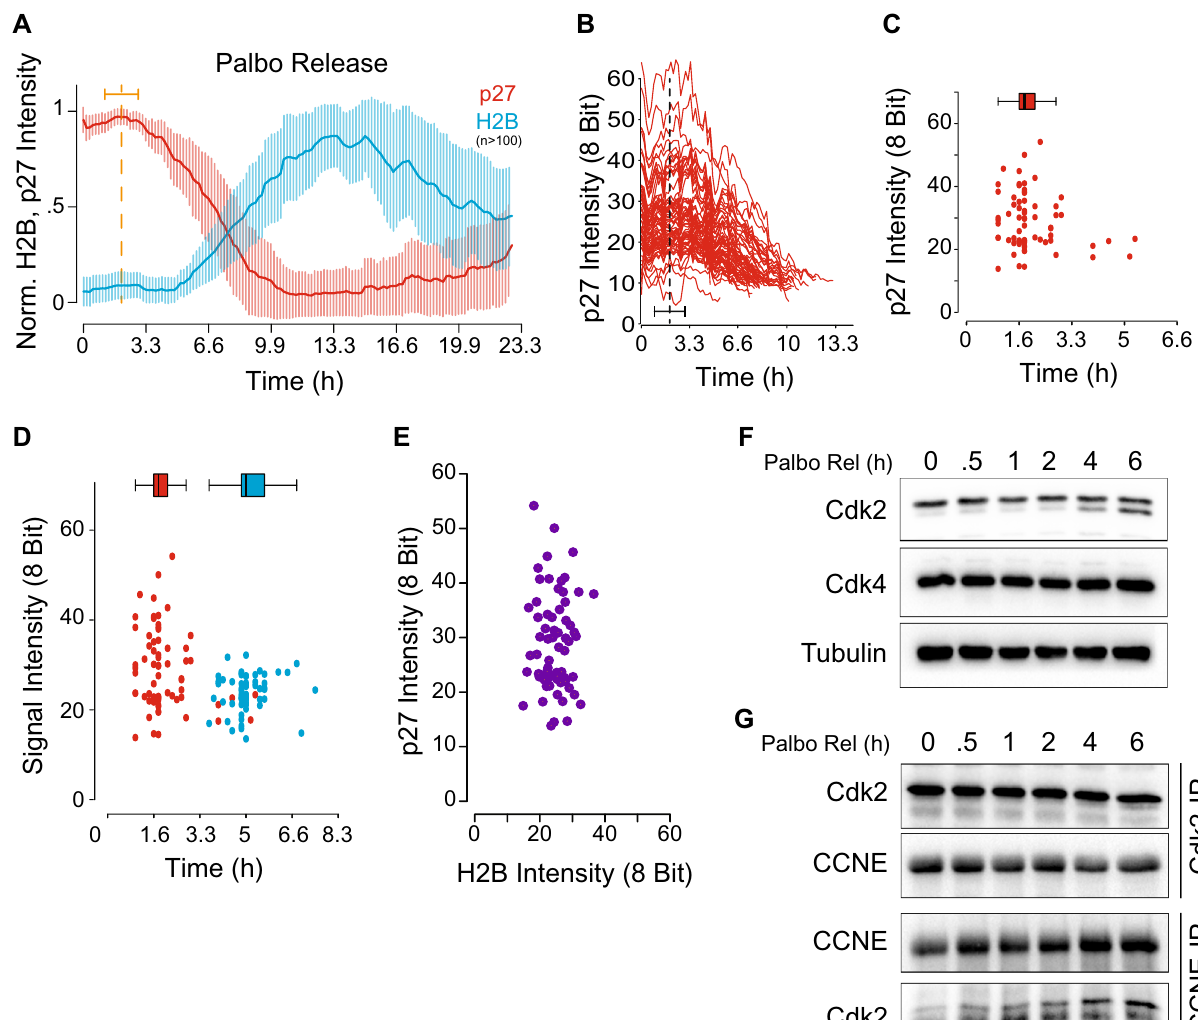
Figure 1. p27-mCherry, a single cell reporter for cell cycle entry. ( A ) Average over single cell p27-mCherry and H2B-eGFP signals during a Palbociclib release. Bold red and blue lines indicate an average over 10 for endogenous p27 or H2B, respectively. Thin vertical red and blue lines indicate the standard deviation at this time point over the past and future 5 time points. ( B , C ) Heterogeneity of single cell p27-mCherry signals. Data derived from ( A ). Note: the p27-mCherry inflection point is independent of a cells p27-mCherry level. Red dots: a cells p27-inflection point. ( D , E ) A cells p27 inflection point does not correlate with S phase entry (measured as 5% increase in H2B-eGFP signal). Red dots: p27-inflection point. Blue dots: S phase entry. Purple dots: single cell correlation between p27-inflection point and S phase entry. ( F , G ) Western blot and immune- precipitate of lysates, as cells treated in A. Note: Cdk2 activation becomes apparent between 2 and 4 h, whereas the complex between Cdk2 and cyclin E is